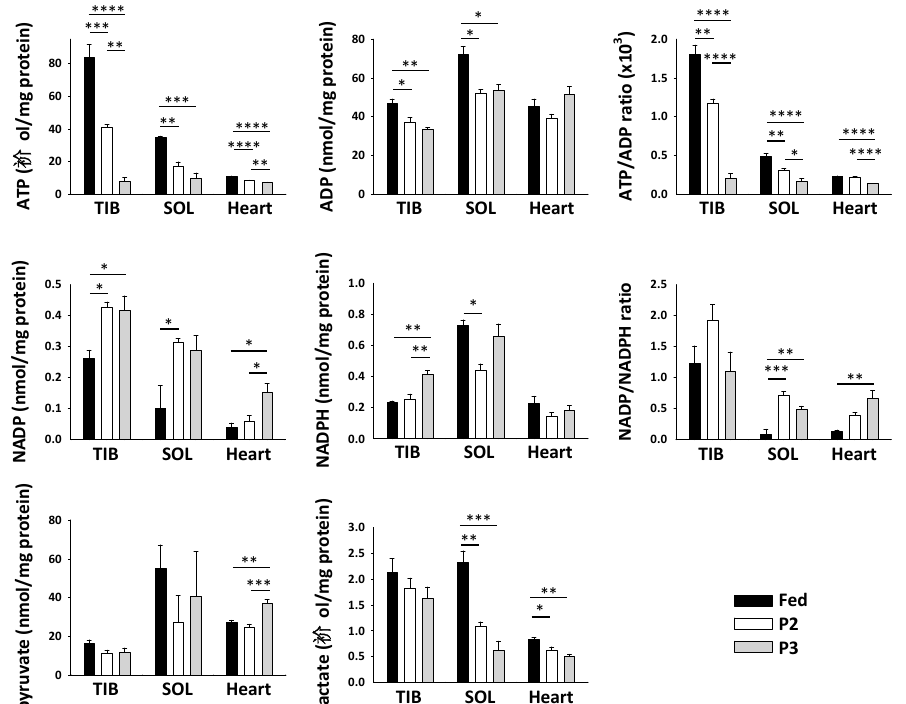
Figure 5. Changes in levels of metabolites and cofactors in muscles of rats during prolonged fasting. Levels of ATP, nicotinamide adenine dinucleotide (ADP), oxidized (NADP) and reduced (NADPH) forms of nicotinamide adenine dinucleotide phosphate, pyruvate, lactate, and the ATP/ADP and NADP/NADPH ratios in tibialis anterior (TIB), soleus (SOL), and heart muscles from fed, phase 2 (P2), and phase 3 (P3) rats are presented as the means ± SEM ( N = 5/group). * p -value < 0.05, ** p -value < 0.01, *** p -value < 0.001, **** p -value < 0.0001 (one-way ANOVA and Tukey tests).